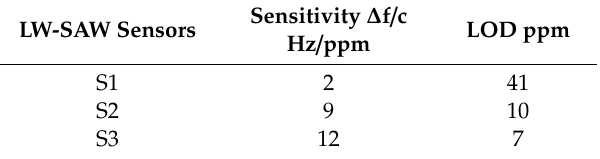
Table 1. Sensitivity and LOD ( ∆ f–frequency change, c-chloroform concentration) for the sensitive